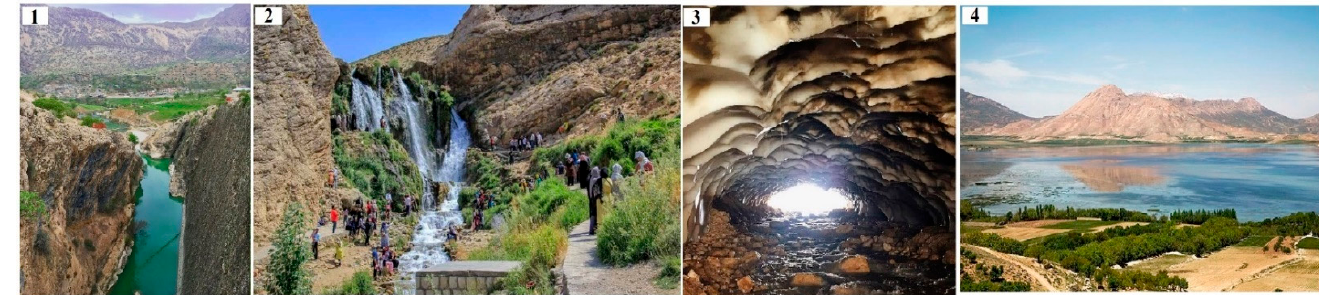
Figure 1. Typical Ecotourism areas across the study region; 1—Dopolan River, 2—Sheikh-Alikhan waterfall, 3—Chama Cave, 4—Choghakhor wetland.